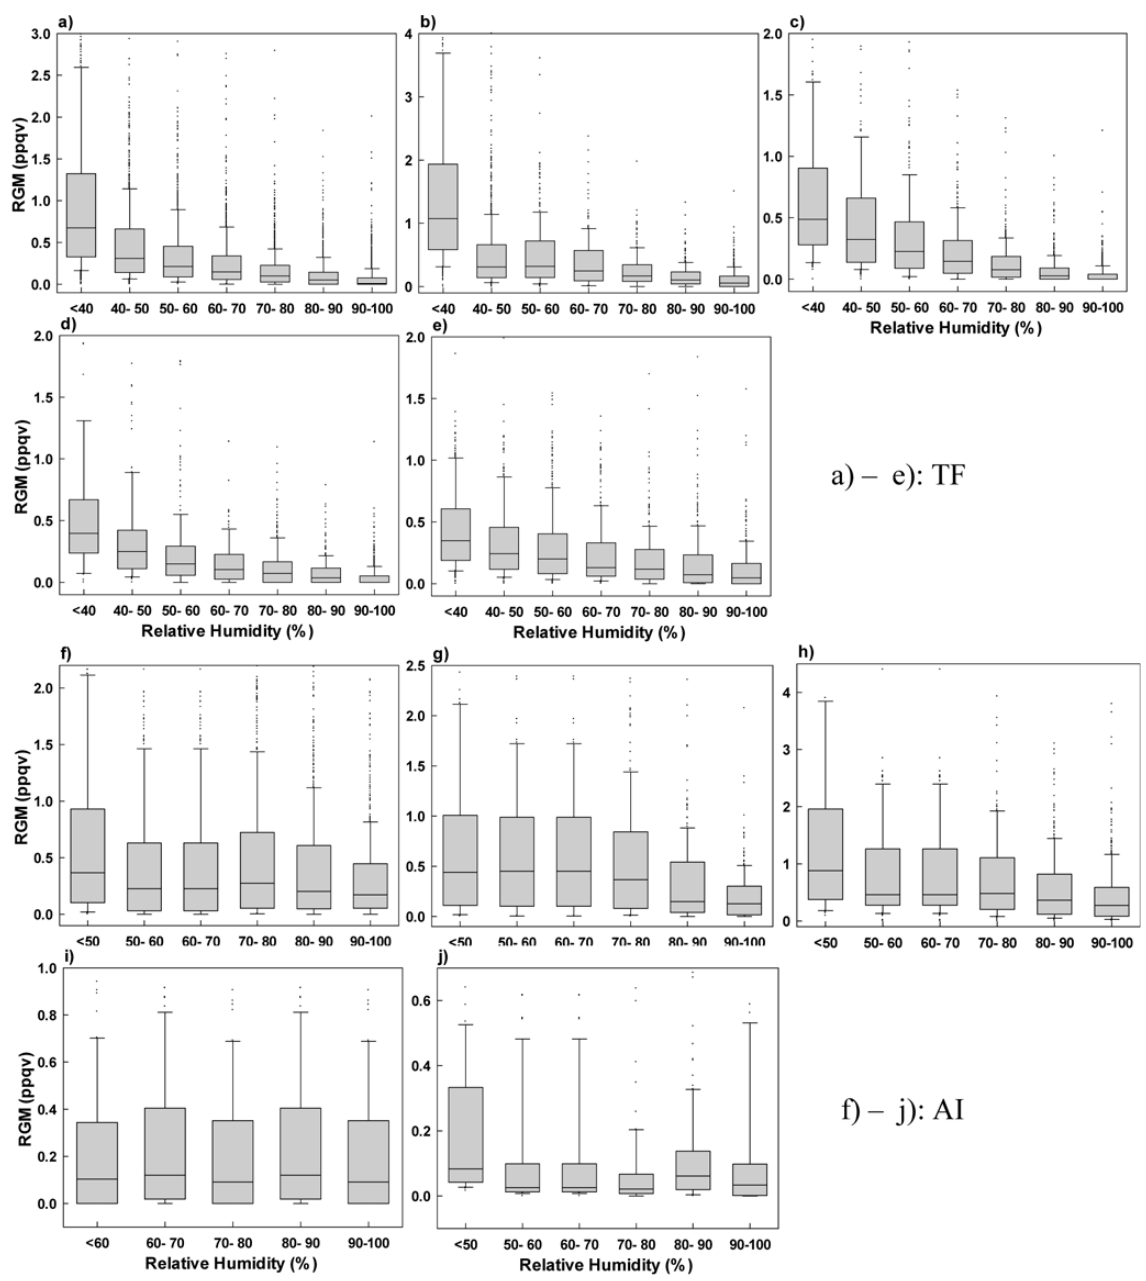
Fig. 13. Relationships between RGM and relative humidity at TF (coastal) (a–e) and AI (marine) (f–j) for all seasons (a, f) , springs (b, g) , summers (c, h) , falls (d, i) , and winters (e, j)